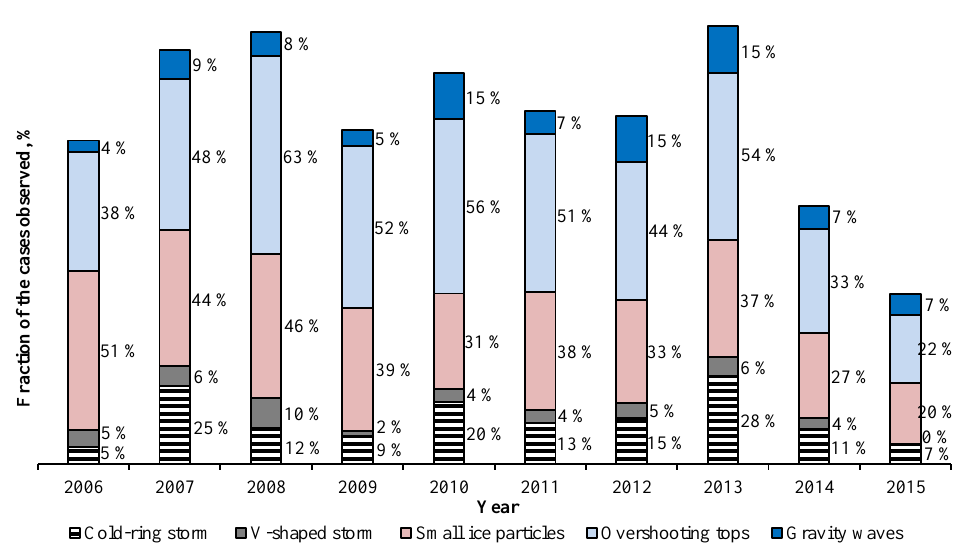
Fig. 7. The fraction of cases (%) with characteristic thunderstorm features identified from weather satellite observations on days with more than 10 lightning flashes detected in Latvia over the period